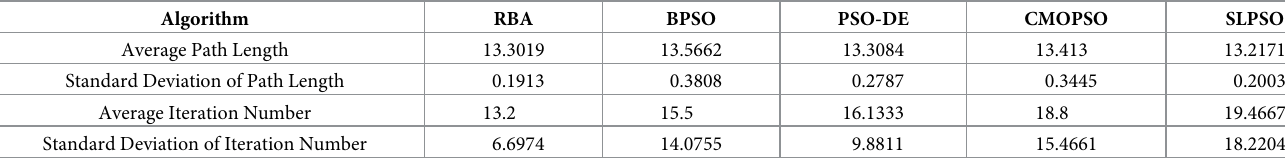
Table 2. Performance comparison between RBA and PSO variants in test case